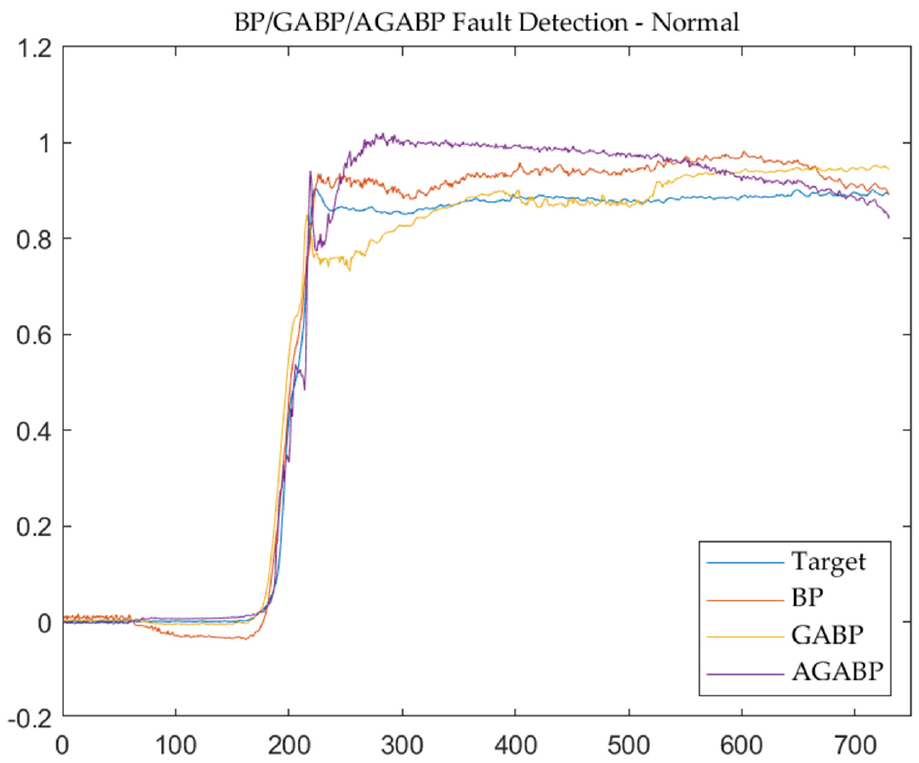
Figure 8. The output of the three models—normal.